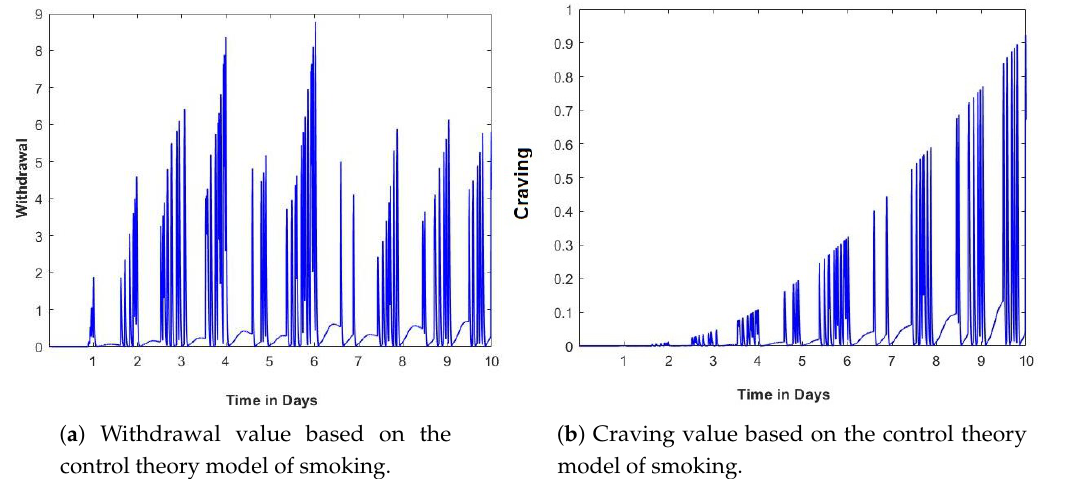
Figure 8. Example of 10 days calculated withdrawal and craving values using the control theory model of smoking and collected data from one of the participants